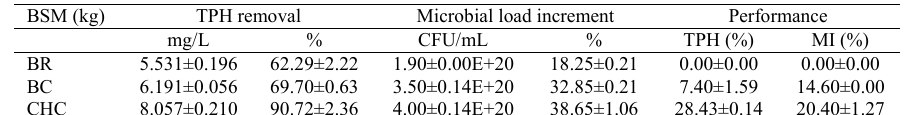
Table 1: Results for BSM impact